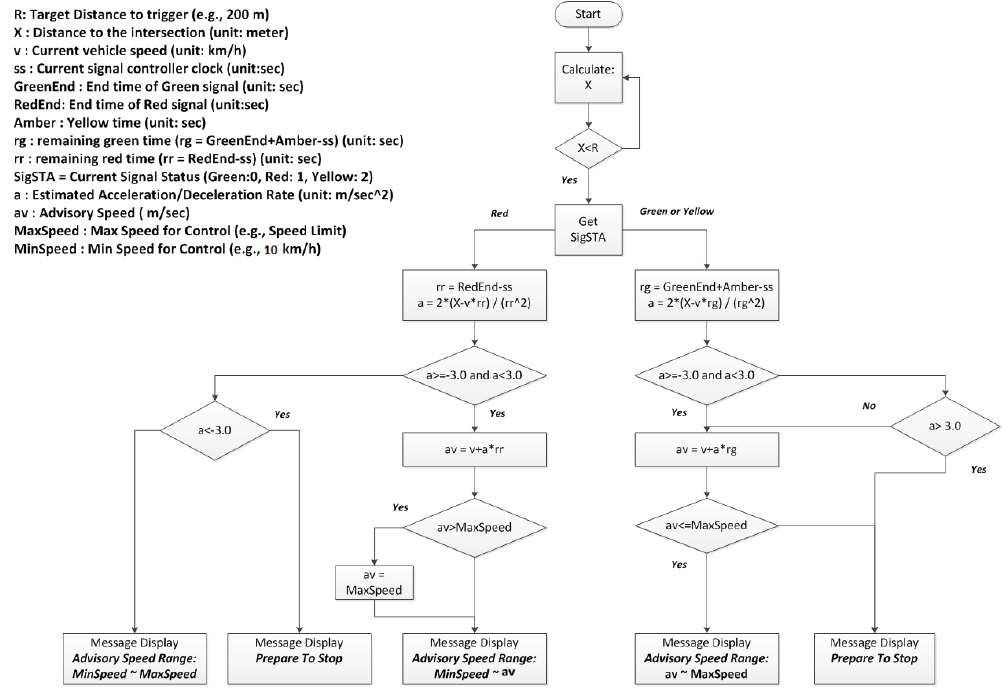
Figure 2. ITSAS Algorithm.